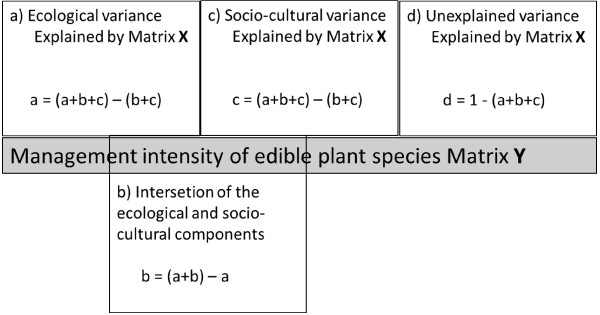
Influences (pure and combined) of ecological (matrix X) and sociocultural (matrix W) explanatory variables on management of edible species (matrix Y). Each CCA model involves different subsets of variation sources. For instance, matrix X affects matrix Y (Y~X) but in X coexists intermingled variation sources a) and b). Modified from Boccard et al. [36]. a) Ecological fraction of management intensity variation that can be explained only by ecological data, b) Sociocultural + ecological data, c) Sociocultural fraction of management intensity variation explained only by sociocultural data, and d) Undetermined data or fraction of management intensity variation explained neither by ecological nor by sociocultural data.